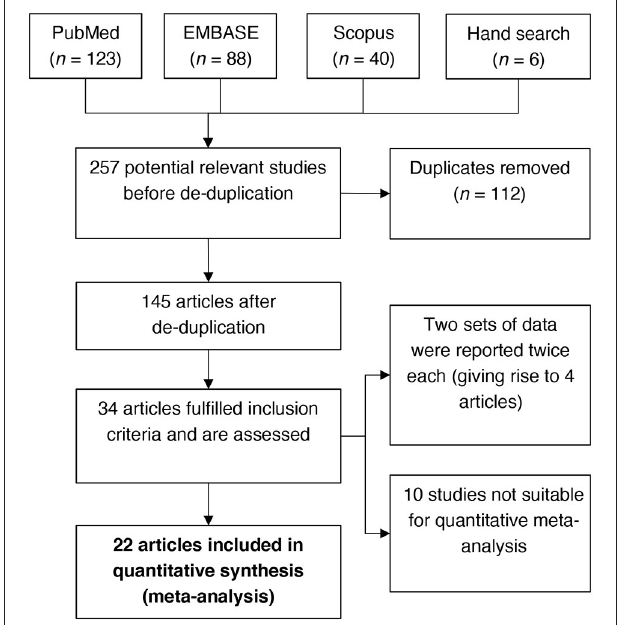
FIGURE 1 | Flowchart of the study selection